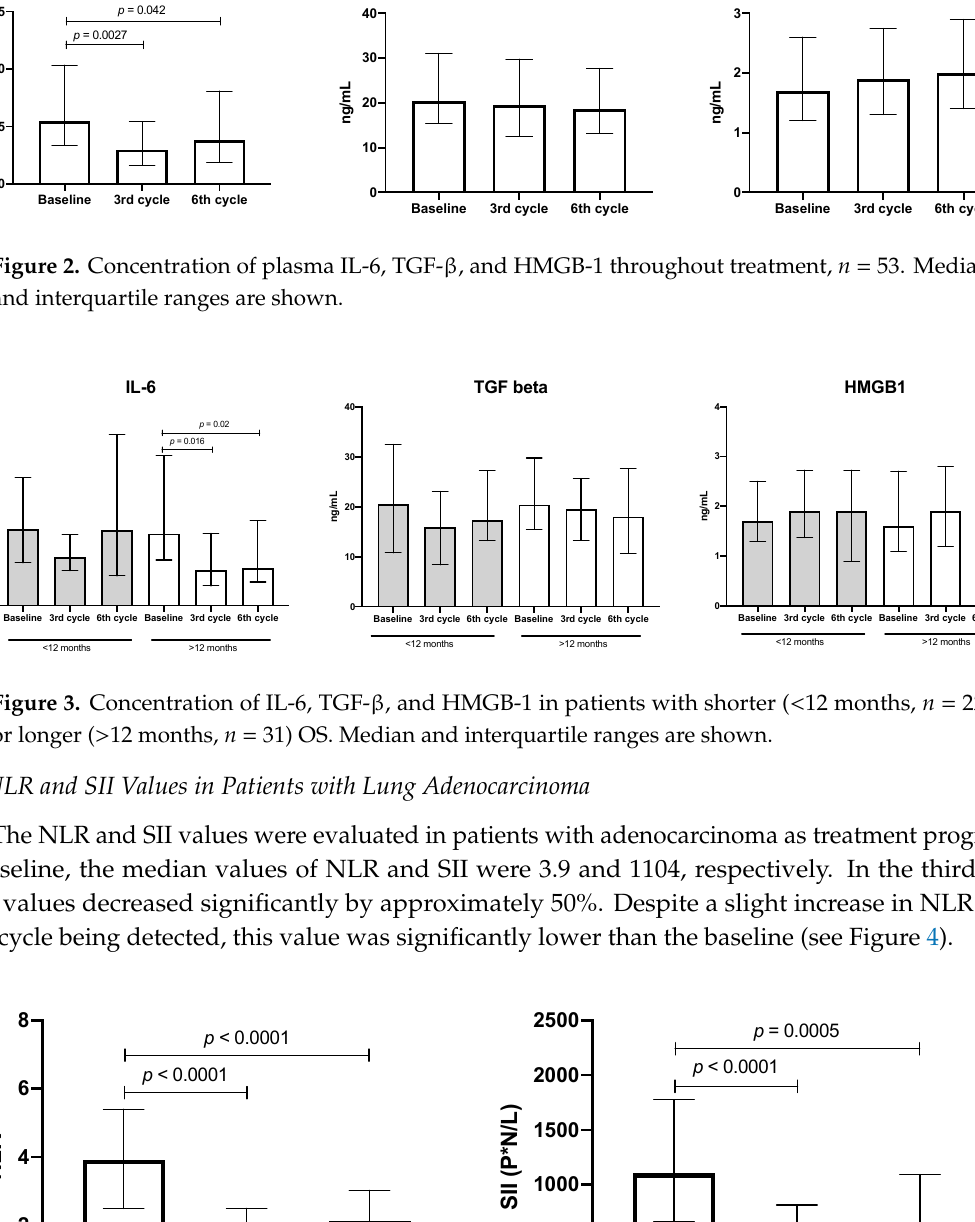
Figure 4. Neutrophil–lymphocyte ratio (NLR) and systemic immune-inflammation index (SII) values during treatment. Median and interquartile ranges are shown ( n = 53).